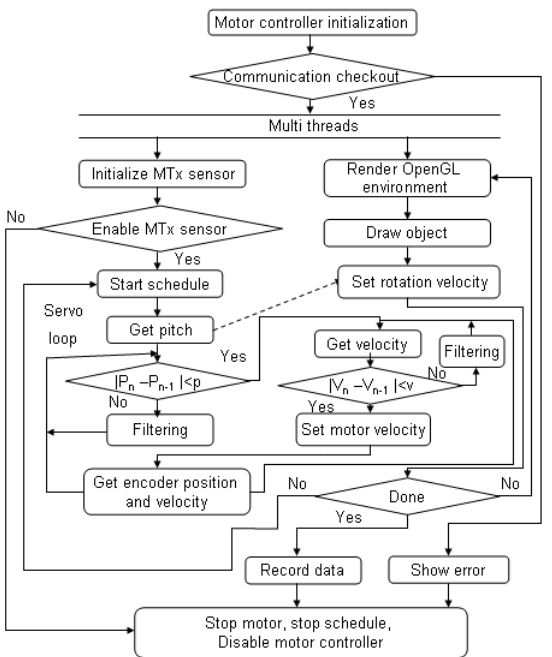
Figure 3. The flow chart of the